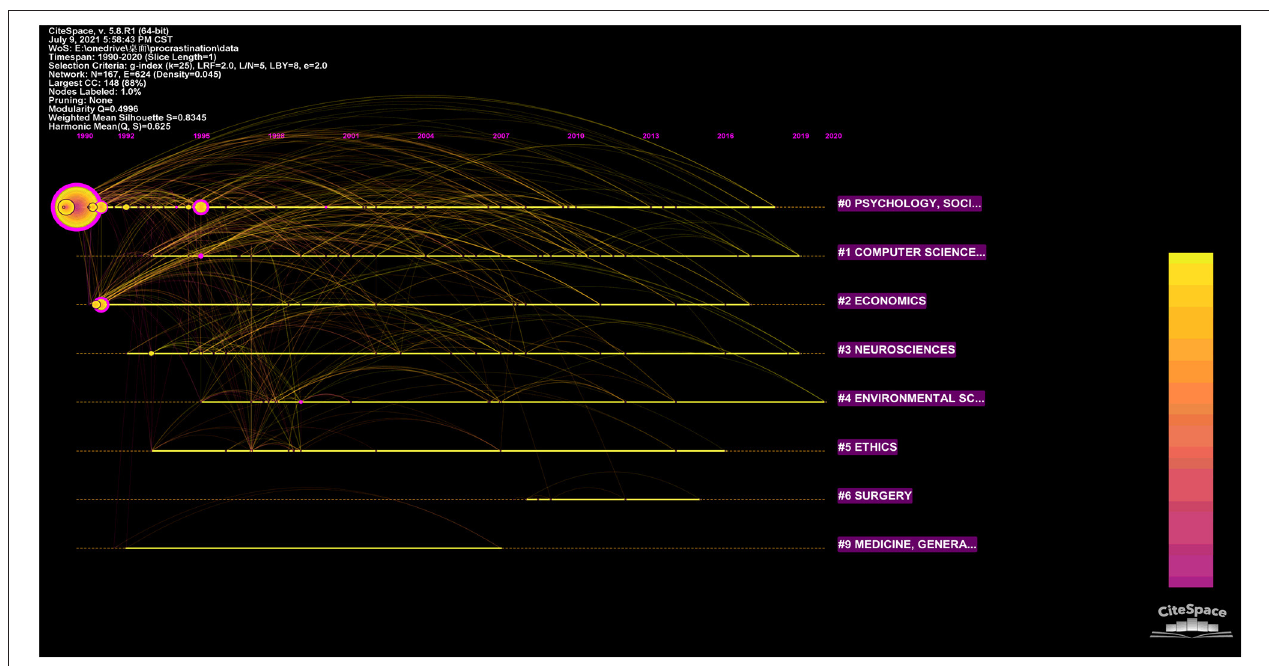
FIGURE 2 | Distribution of categories involved in procrastination